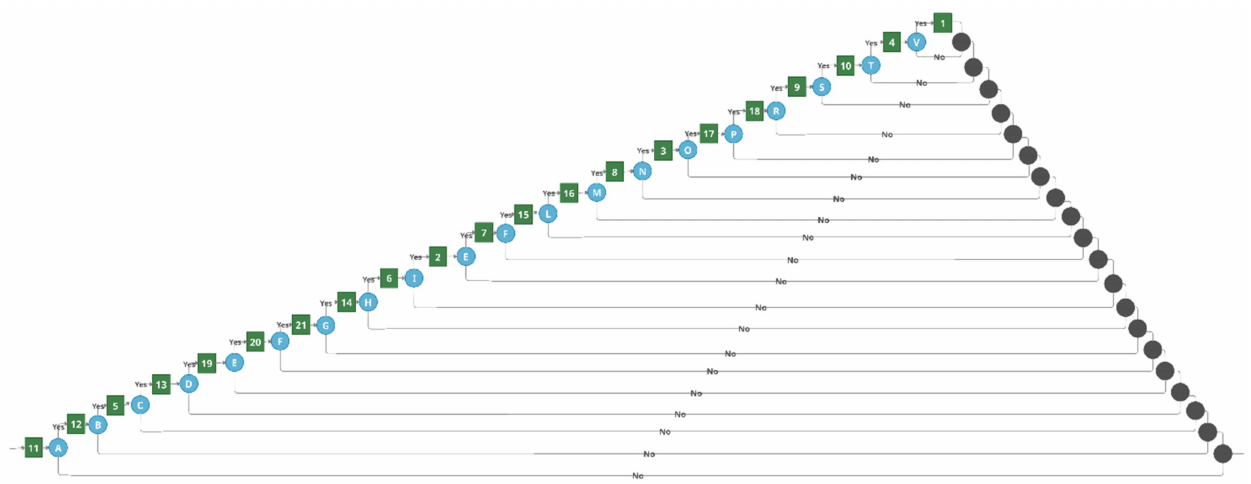
Figure 6. Result of BTCG transformation for the competence tree, presented in Figure 3 when all competencies are sequentially dependent.